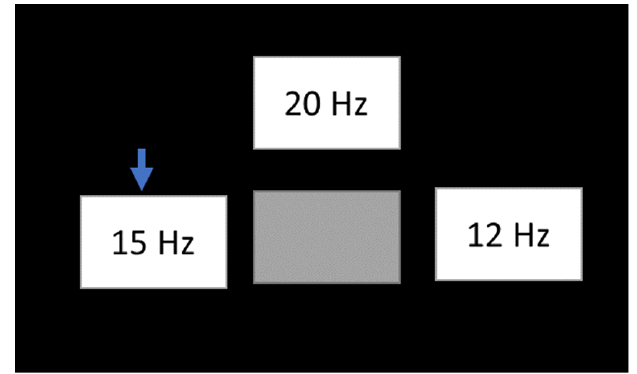
Figure 5. Stimuli frequencies.